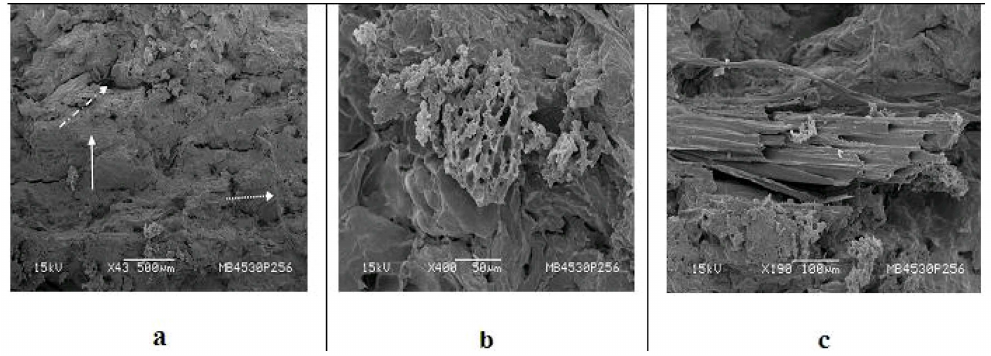
Figure 7. SEM photographs of COC—pure glycerol-banana fiber composite after the tensile test: ( a ) panoramic view of surface showing matrix, fibers and some cracks; ( b ) zoomed image of the encircled region near the crack edge seen ( a ); ( c ) fractured fiber embedded in the